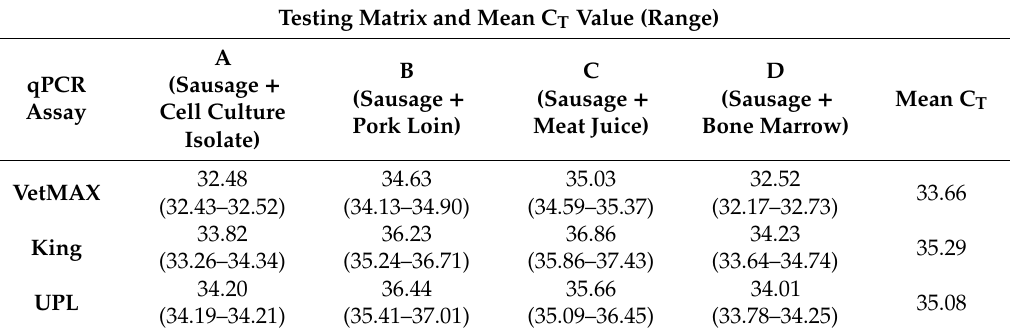
Table 1. C T values generated using automated extraction for all sample